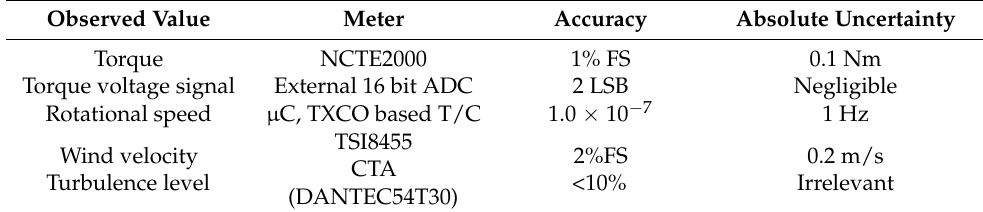
Table 3. Accuracies of measurement chain